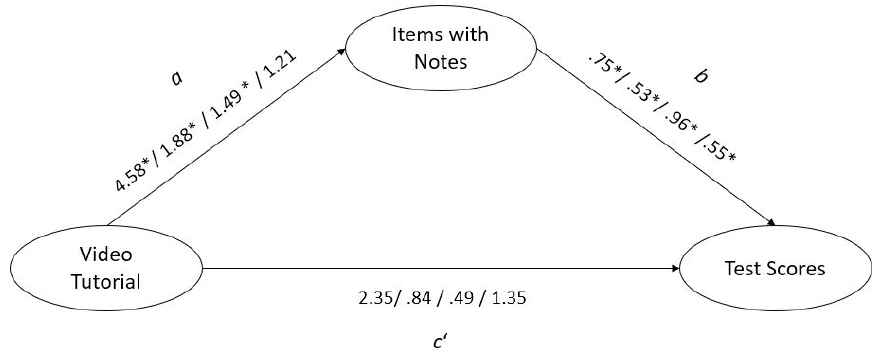
Figure 2. Mediation model. Sum / I-S-T 2000 R / WIT-2 / Newly constructed. * p < 0.05 .